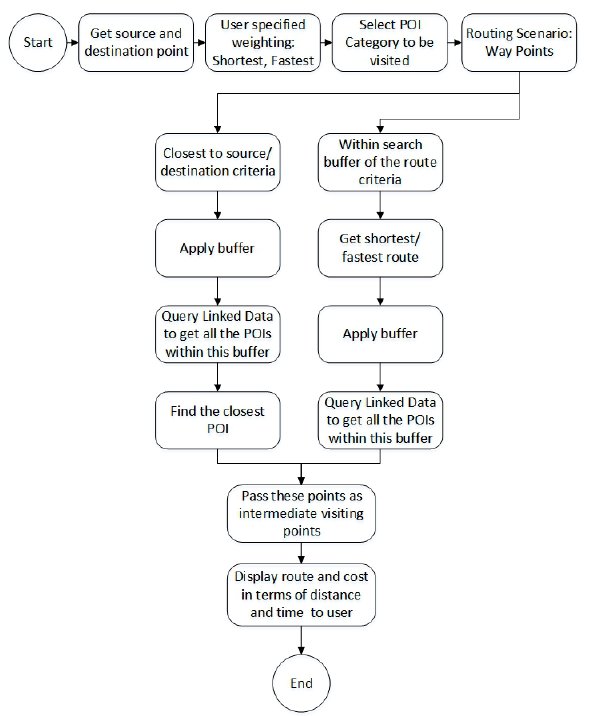
Figure 2. Routing scenario flowchart